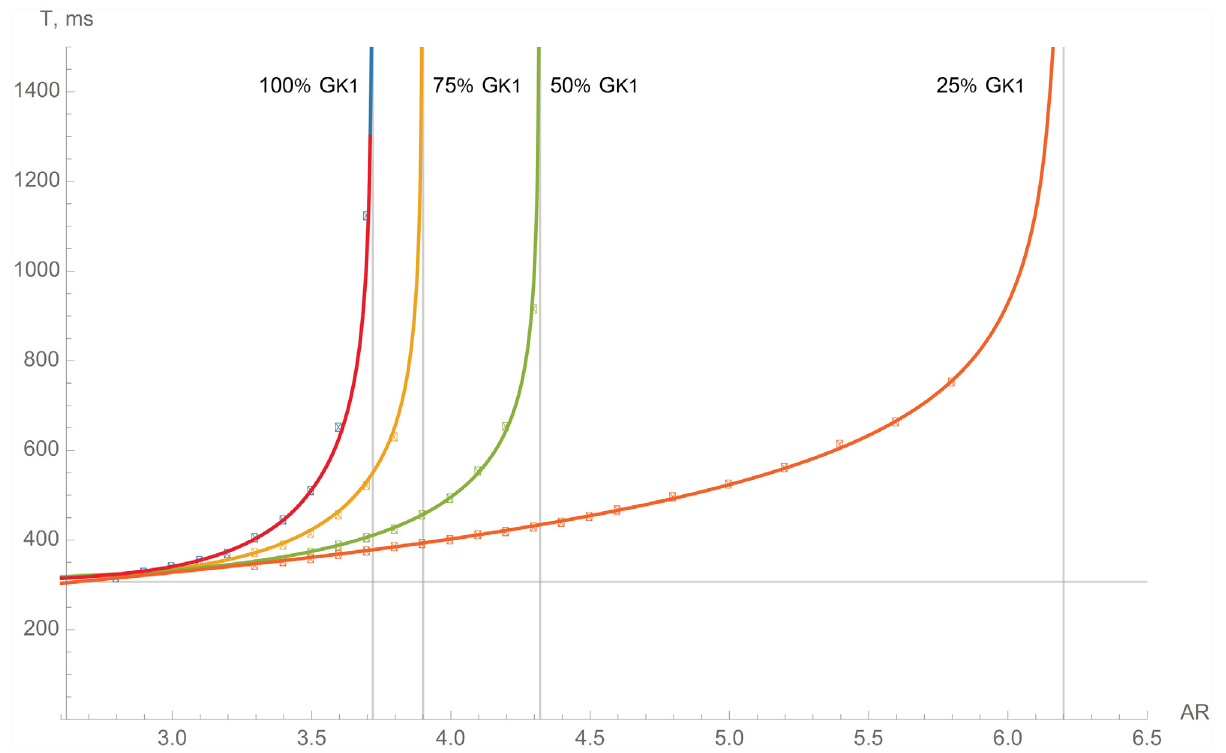
Fig 6. The dependencies of the critical period of stimulation on the AR for normal cardiomyocytes (red line) and with the inward rectifier potassium current I K 1